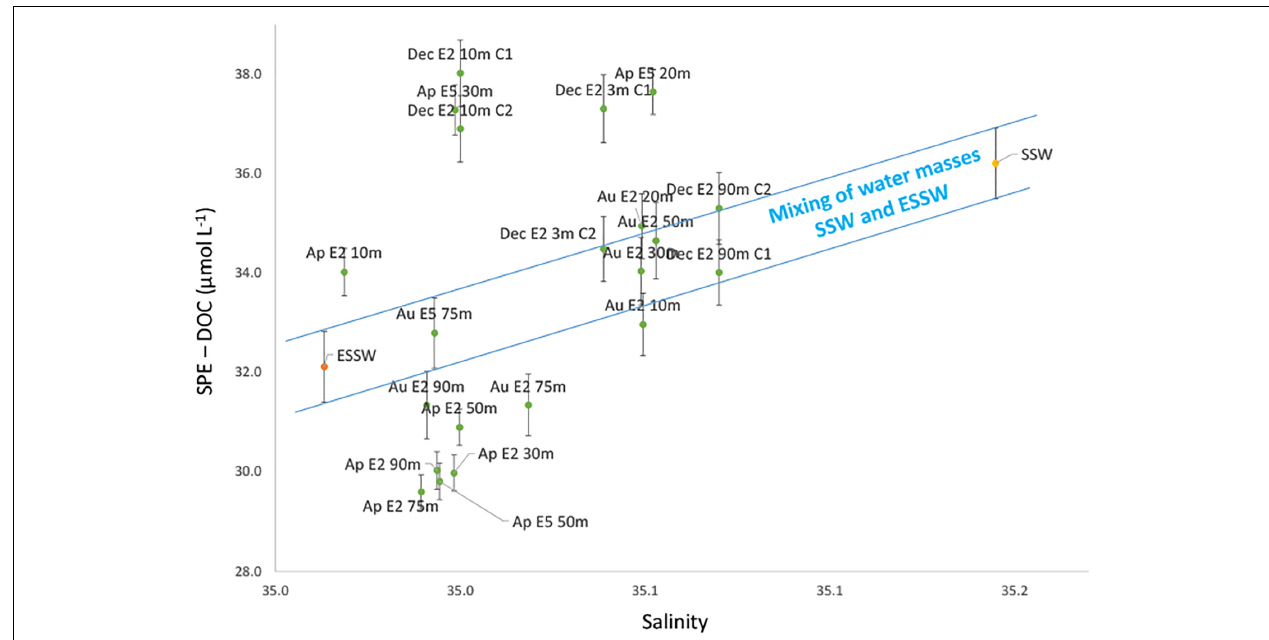
FIGURE 6 | Conservative mixing model for SPE-DOC. The blue lines mark the range of conservative mixing of the defined end members (ESSW and SSW). Green dots represent the samples from the Coastal Cold Waters (CCW, n = 21). The orange dot is the average of the samples from the Equatorial Subsurface Waters (ESSW, n = 5) and the yellow dot the Surface Subtropical Waters (SSW, n = 13). Error bars indicate the analytical error for SPE-DOC concentrations. The samples are labeled according to month of sampling (Ap = April, Au = August, and Dec = December), distance to the coast (station 2 – E2, station 5 – E5, and station 7 – E7), and water